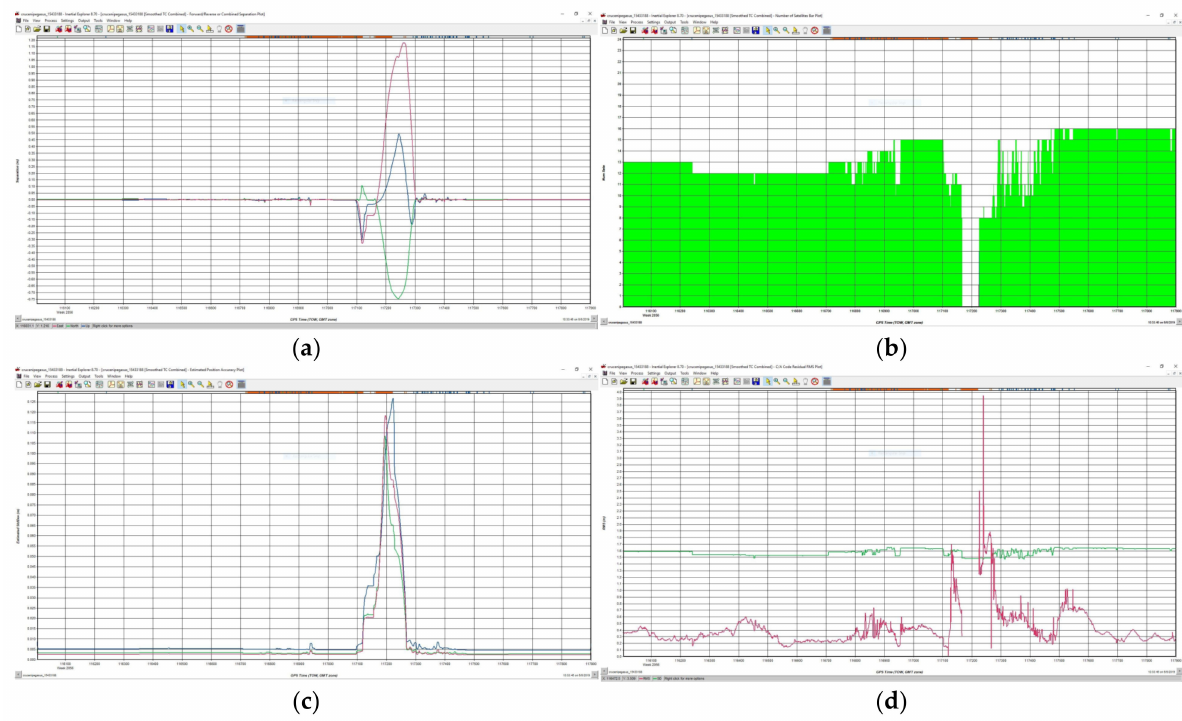
Figure 28. 3D scanning of the objective CRUCENI PUMPING STATION on 03.06.2019: ( a ) View of scan accuracy (Combined separation); ( b ) The number of visible satellites at the time of the scan; ( c ) RMS values; ( d ) Estimation of data accuracy (X, Y, Z and